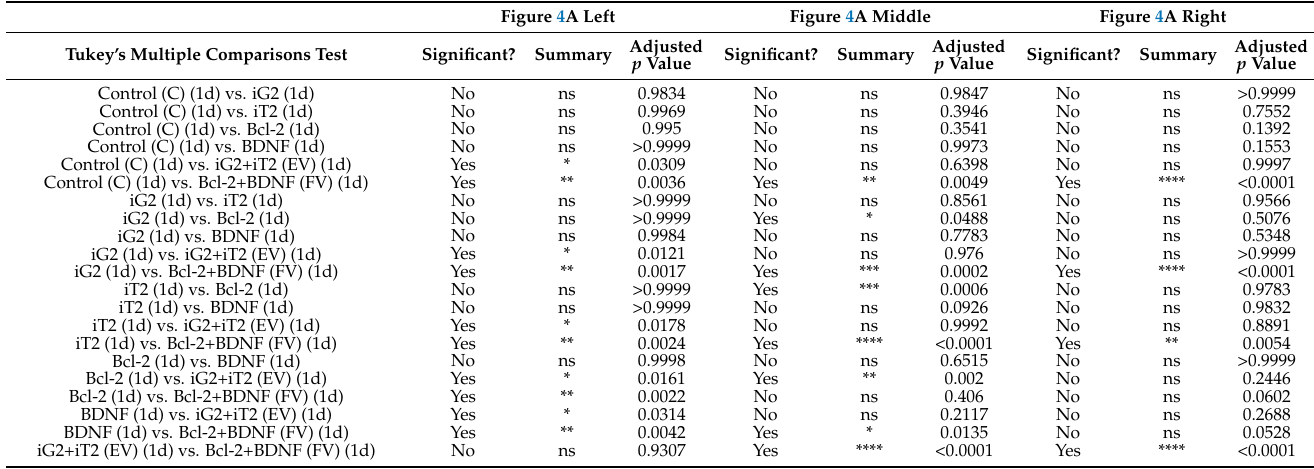
Table 1. Ordinary one-way ANOVA followed by a post hoc Tukey’s test to Figure 4A. Statistically significant * p < 0.05, ** p < 0.01, *** p < 0.001 or **** p < 0.0001. Figure 4A Left Figure 4A Middle Figure 4A Right Tukey’s Multiple Comparisons